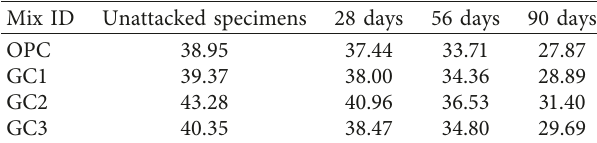
Figure 8: Variation of (a) percentage weight loss and (b) compressive strength after the acid test as a function of curing period. Table 4: Weight loss in the geopolymer and OPC concrete mix Table 5: Compressive strength values of the geopolymer and OPC percentage after the acid test for different curing periods. concrete mixes after the acid test for different curing